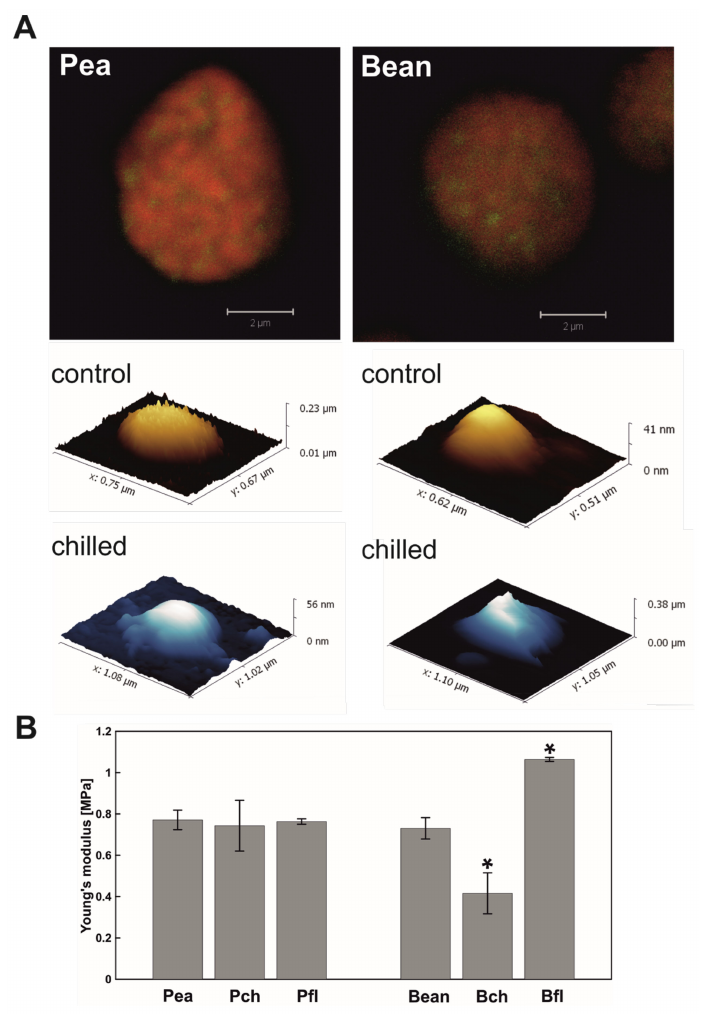
Figure 2. Characterisation of plastoglobules (PGs) from pea and bean plants: ( A ) localisation of PGs (green) in chloroplasts (red) observed with a CLSM (Confocal Laser Scanning Microscope), and topology of PGs in control conditions (yellow-to-white colouring) and after seventh day of low-temperature treatment (blue-to-white colouring) using AFM techniques; ( B ) elasticity of isolated PGs measured via Young’s modulus using AFM from mature plants in control conditions (Pea, Bean), after seven days of low-temperature treatment (ch), and in first leaves (fl). Presented data are mean values ± SD from three independent experiments; pairs of results marked with an asterisk differ significantly at p = 0.05 (one-way ANOVA with posthoc Tukey